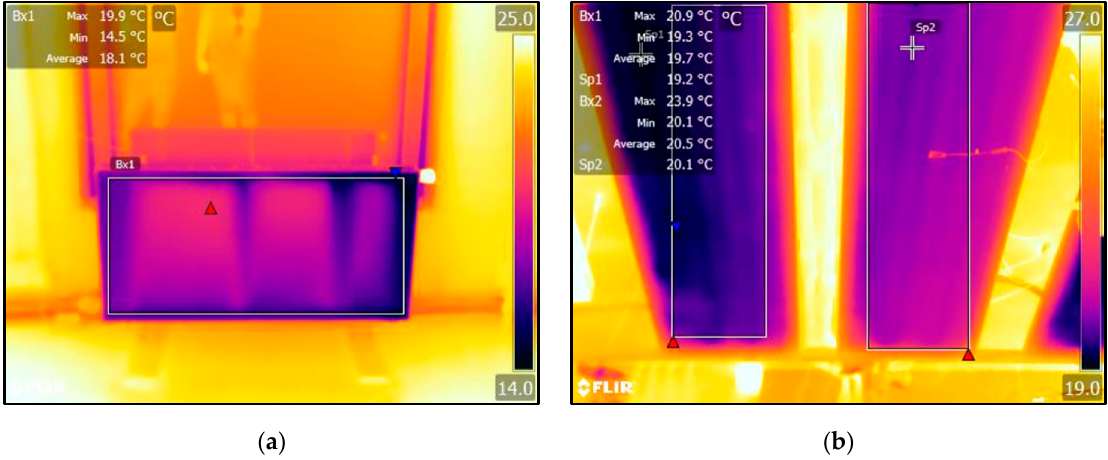
Figure 12 . Thermal image of radiator HIGH ( a ) and of ceiling panels LOW ( b ). Figure 12. Thermal image of radiator HIGH ( a ) and of ceiling panels LOW ( b ).